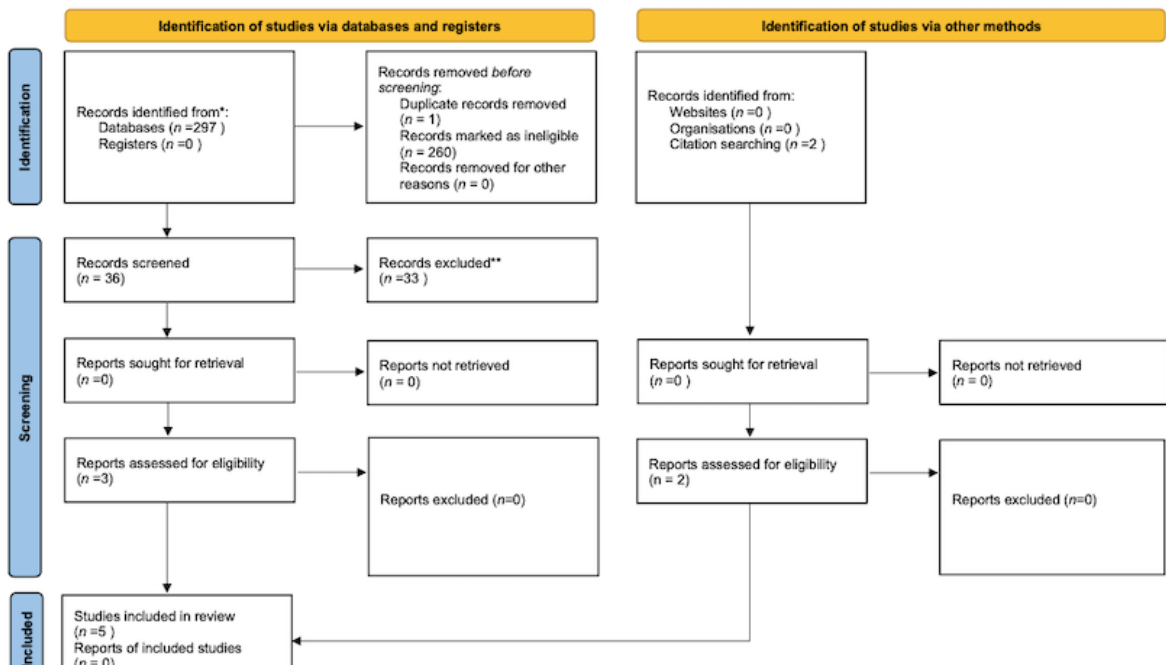
Figure 1. Flow chart of identification and selection studies [29]. * Consider, if feasible to do so, reporting the number of records identified from each database or register searched (rather than the total number across all databases/registers). ** If automation tools were used, indicate how many records were excluded by a human and how many were excluded by automation